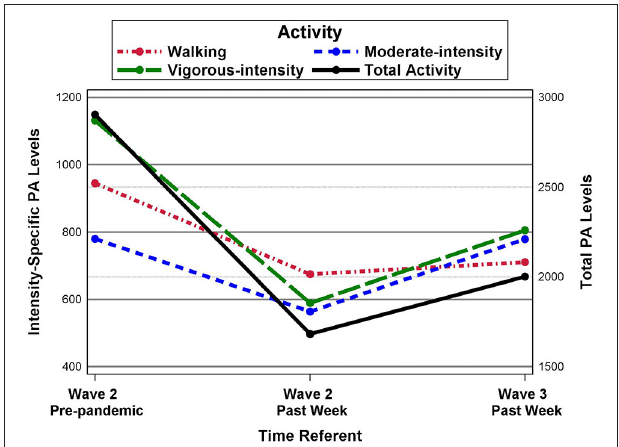
FIGURE 1 | Longitudinal changes in MET-minutes/week of total and intensity-specific physical activity.